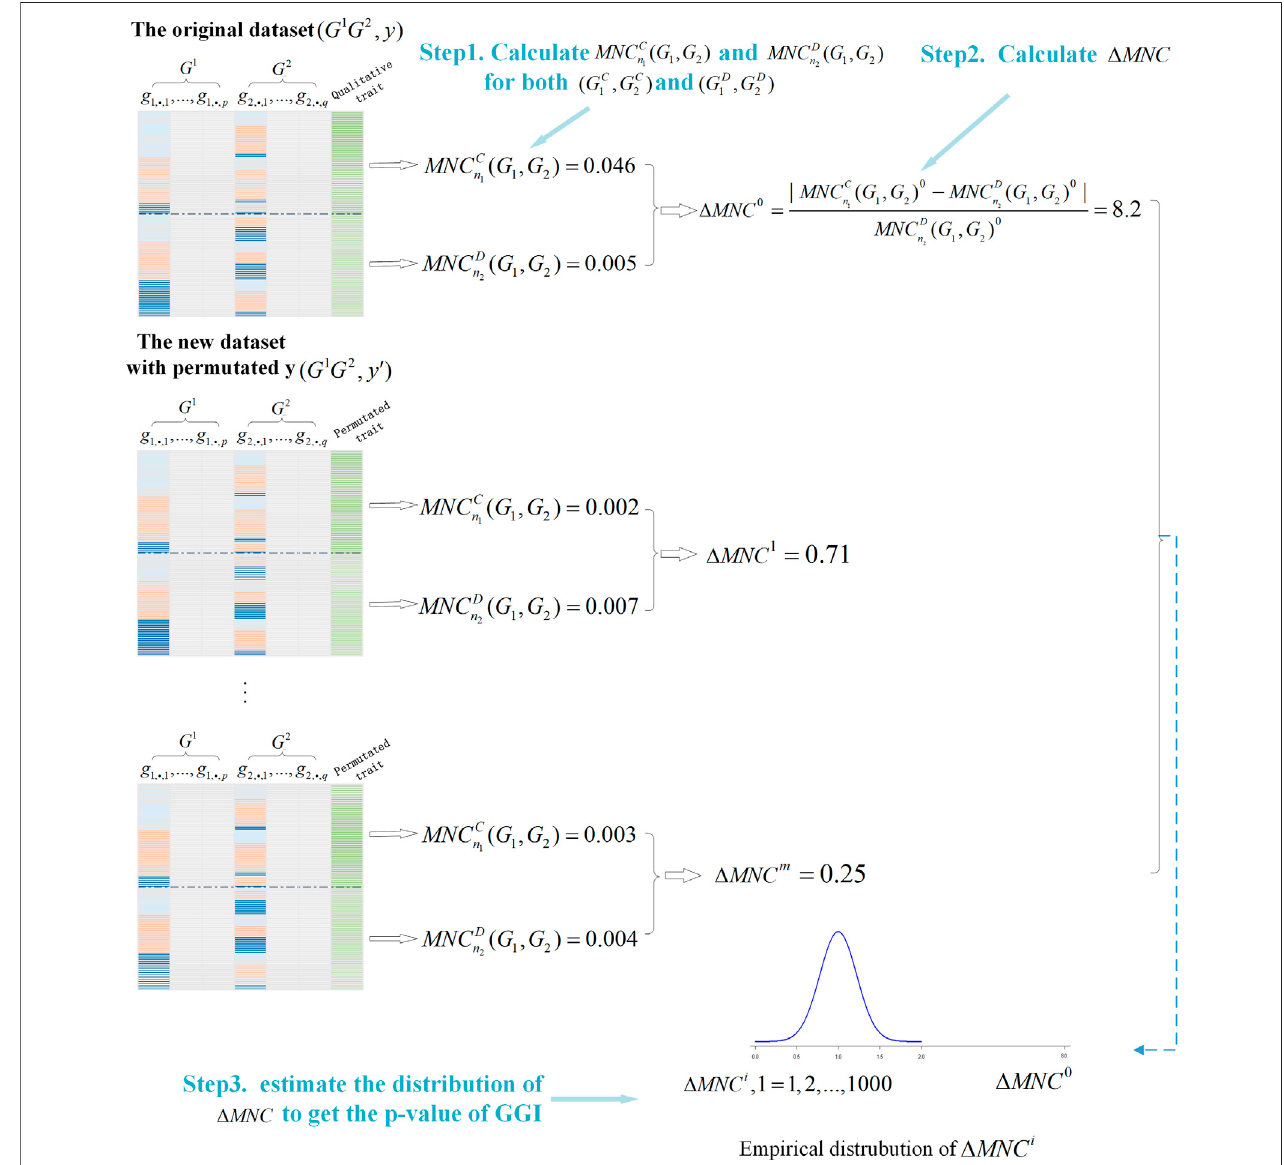
FIGURE 1 | Illustration of the Gene-Based gene-gene interaction through a Maximal Neighborhood Coef fi cient (GBMNC) work fl ow for detection of gene-based, gene-gene interaction.